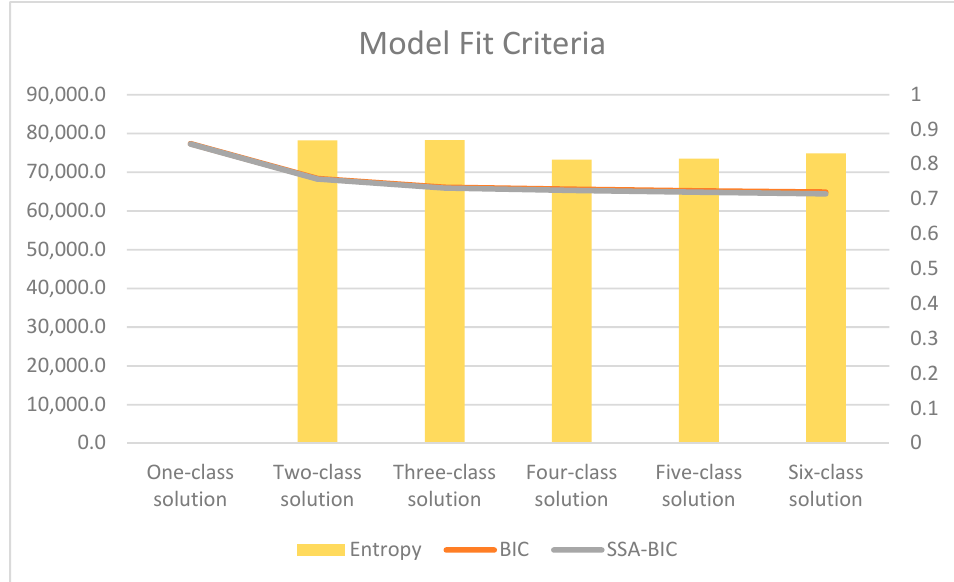
Figure 1. Model fit criteria for six-class solution.